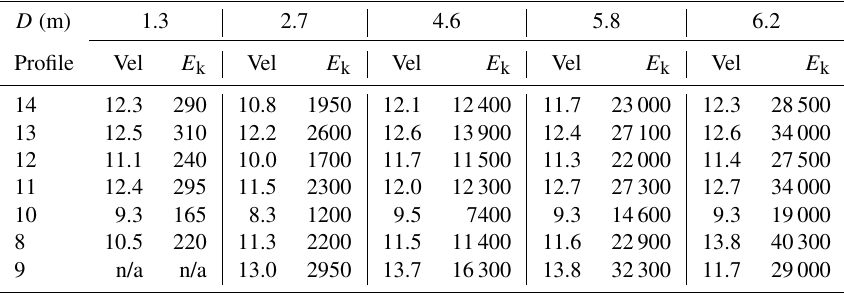
Table 2. Predicted velocity (ms − 1 ) and kinetic energy (kJ) of falling blocks at town border ∗